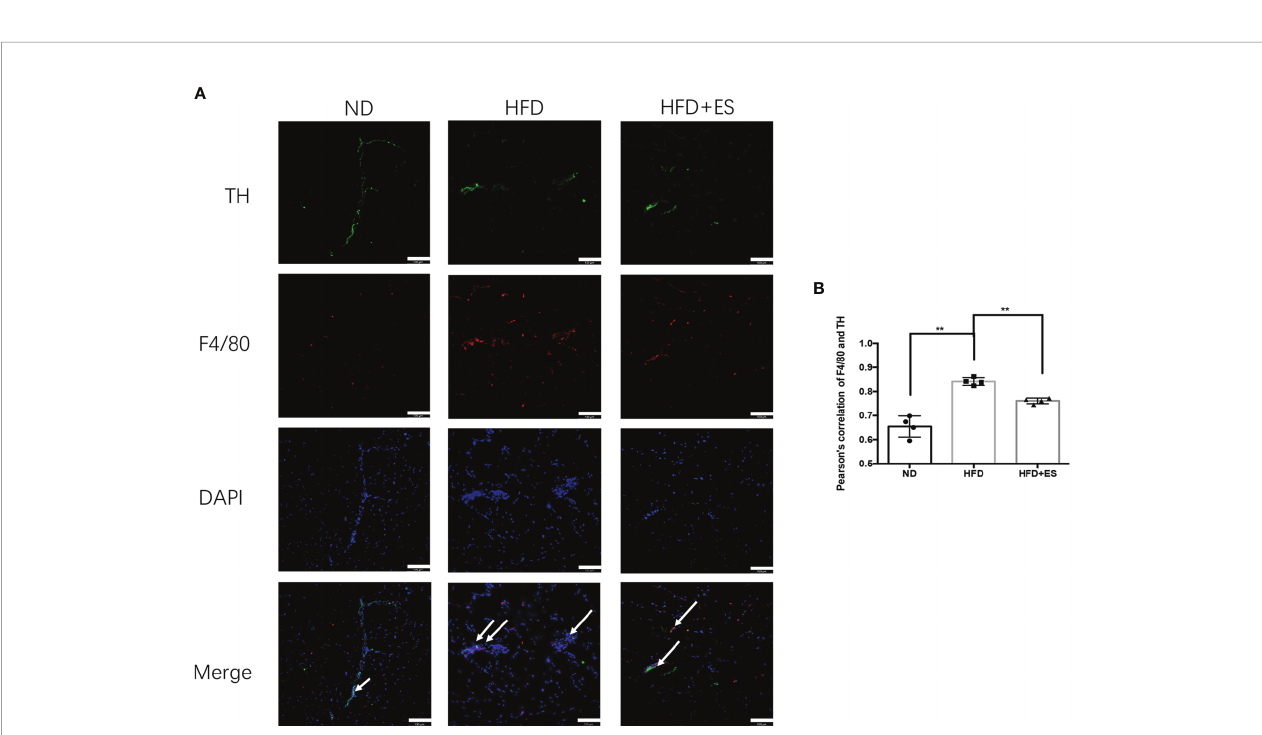
FIGURE 4 | ES suppression of nerve-associated macrophages (NAMs) in eWAT. (A) Representative images showing TH (green), F4/80 (red), and DAPI (blue) fl uorescence (scale bar, 100 m m). The white arrows in the merged image indicate NAMs. (B) Correlation between F4/80 and TH as indicated by Pearson correlation analysis (n = 4, ** P <